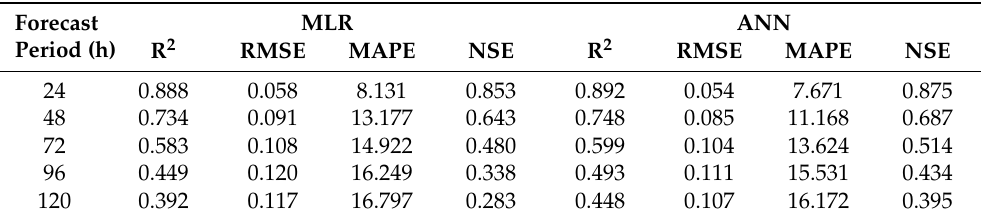
Table 3. The performance evaluation of the combined model. Units of the RMSE and the MAPE are gram per litres and percent respectively.